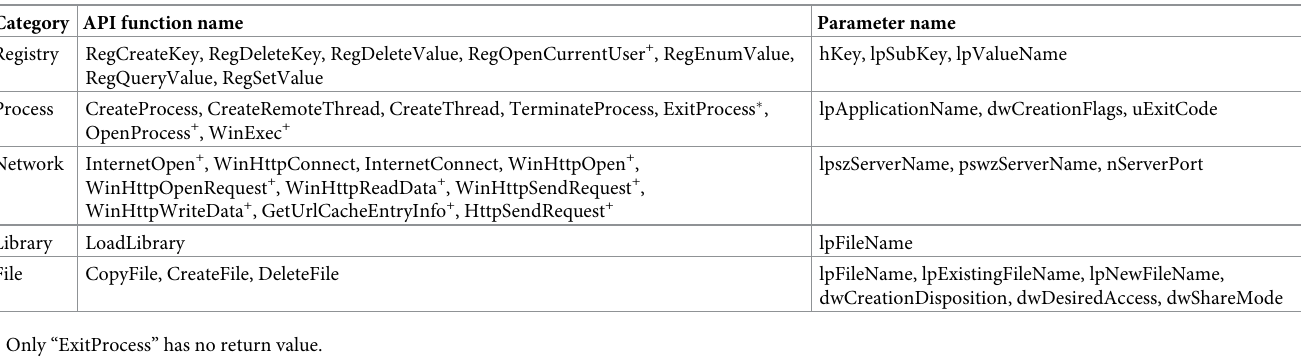
Table 1. Windows API function names and parameter types used in this